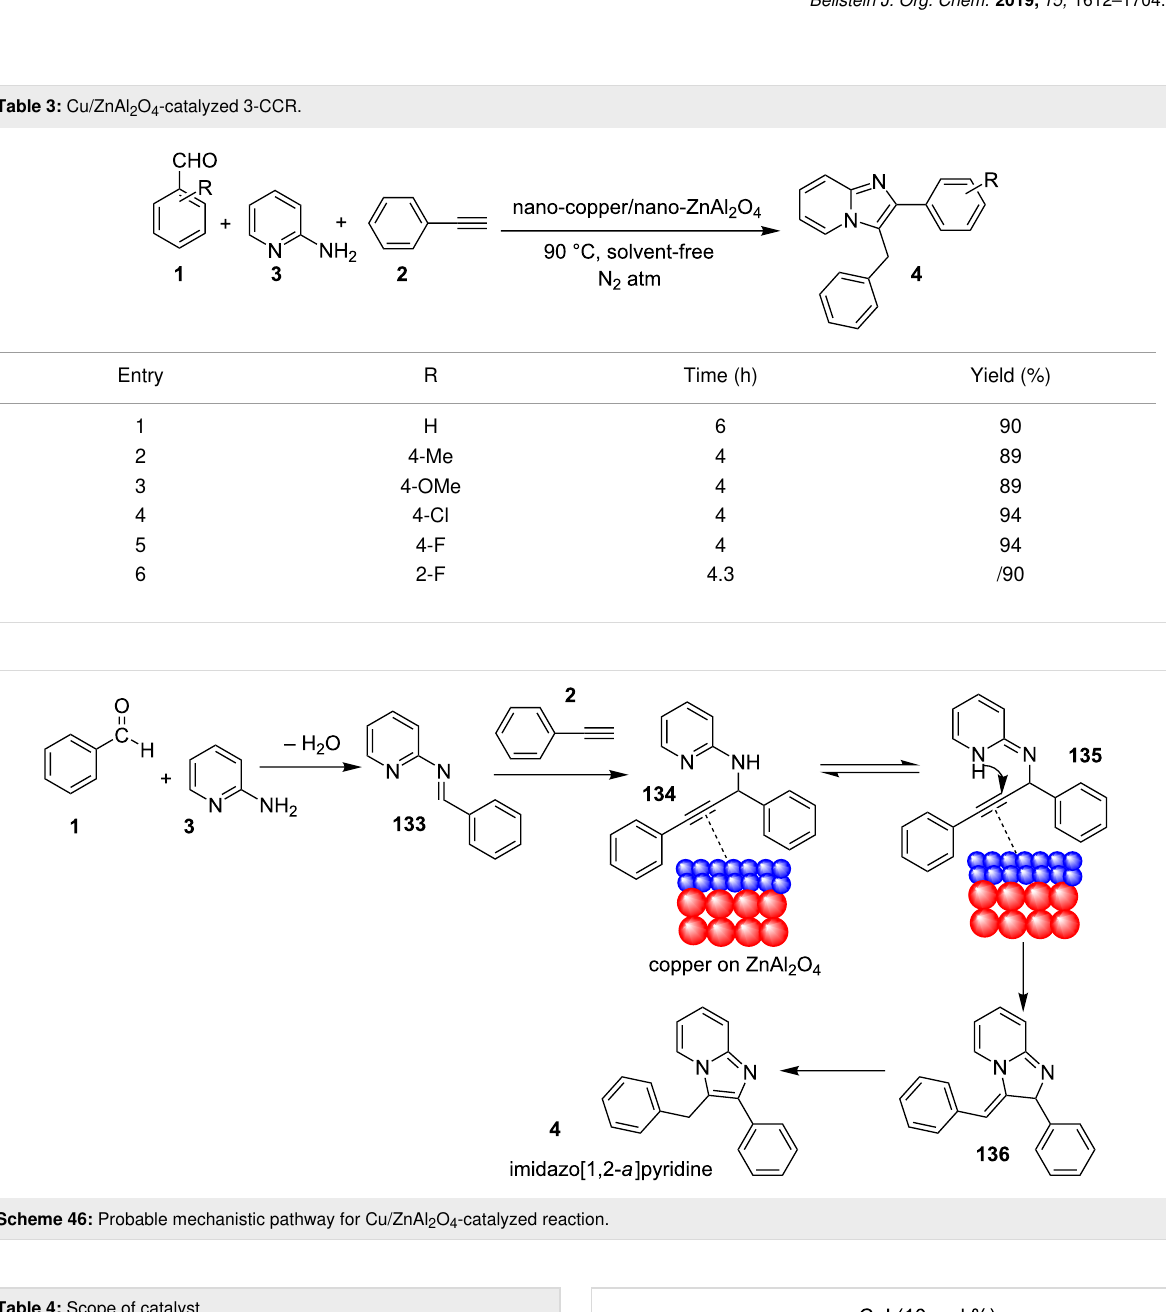
Table 4: Scope of